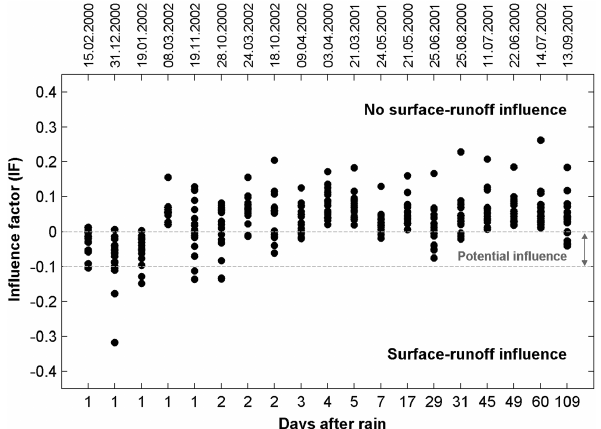
Figure 5. Difference of the means of the normalised temperatures of 19 SRT which represent a surface-runoff area within 1000m radius areas at the outlet of wadis and the normalised temperature of the central area (CAT) of the DS. Strong negative values represent a surface-runoff influence while values above 0 indicate no surface- runoff influence. The range between − 0.1 and 0 requires further analysis as both surface runoff and influences from wind, currents, and groundwater can cause minor negative IF